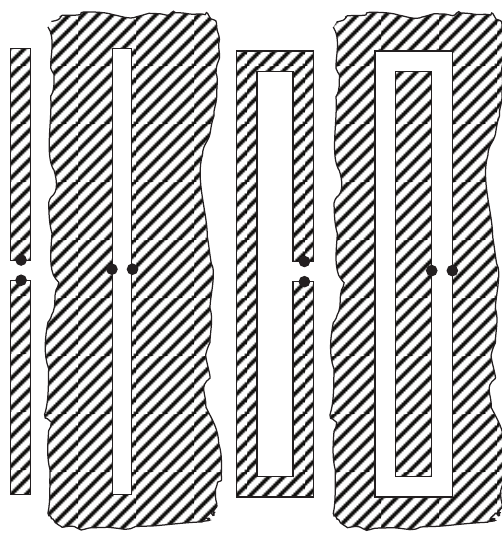
Figure 1: Dipole and folded dipole as complementary